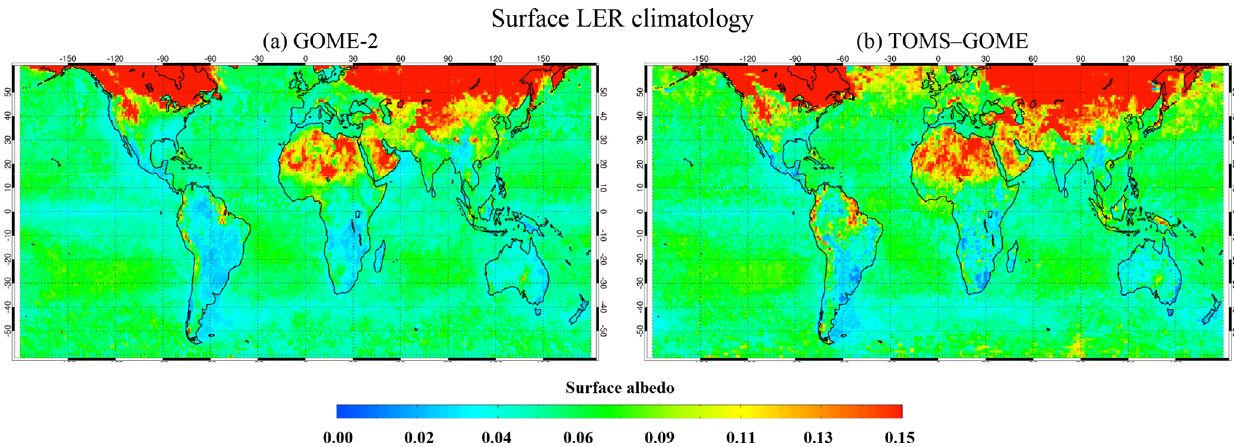
Figure 10. Map of surface LER data for 440nm in February based on GOME-2 observations for 2007–2013 (Tilstra et al., 2017b) (a) and TOMS–GOME data for 1979–1993 (b) .